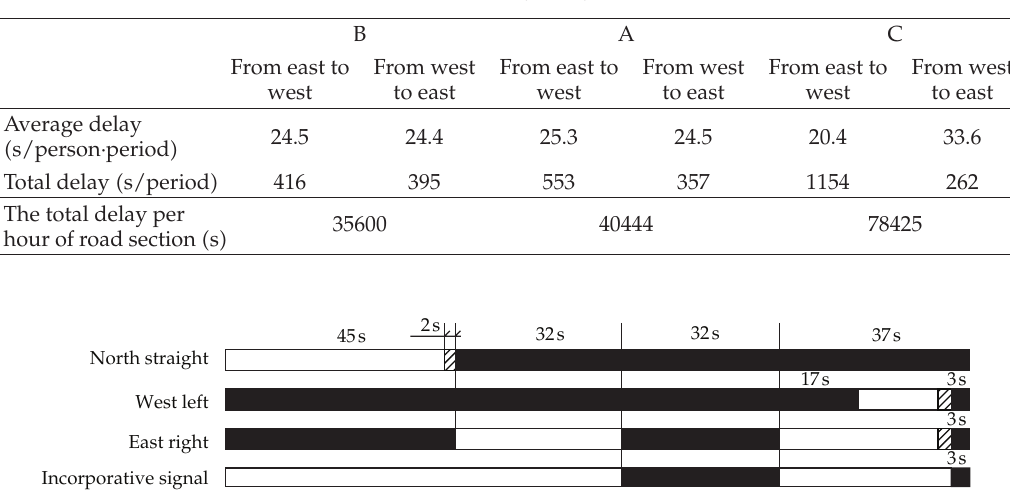
Table 2: Pedestrian actuality delays of B, A, and C.